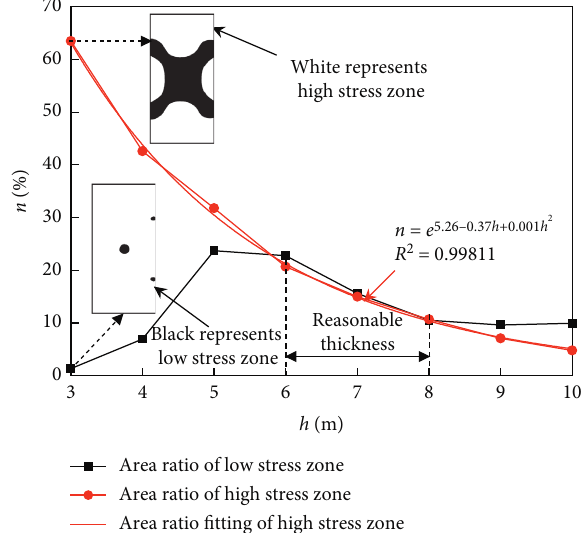
Figure 10: Area ratio distributions of low and high stress zones in ARBBS with different